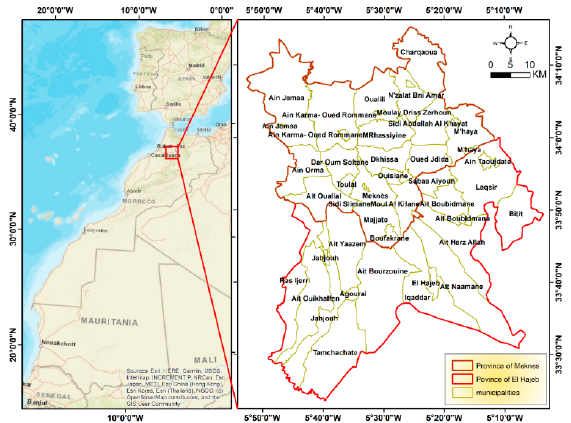
Figure 1. PaPOE Study